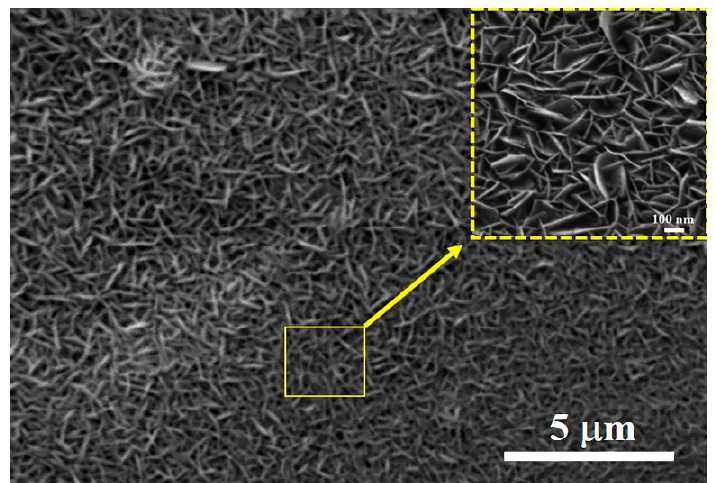
Figure 10. Surface morphologies of hydrothermal conversion coatings.